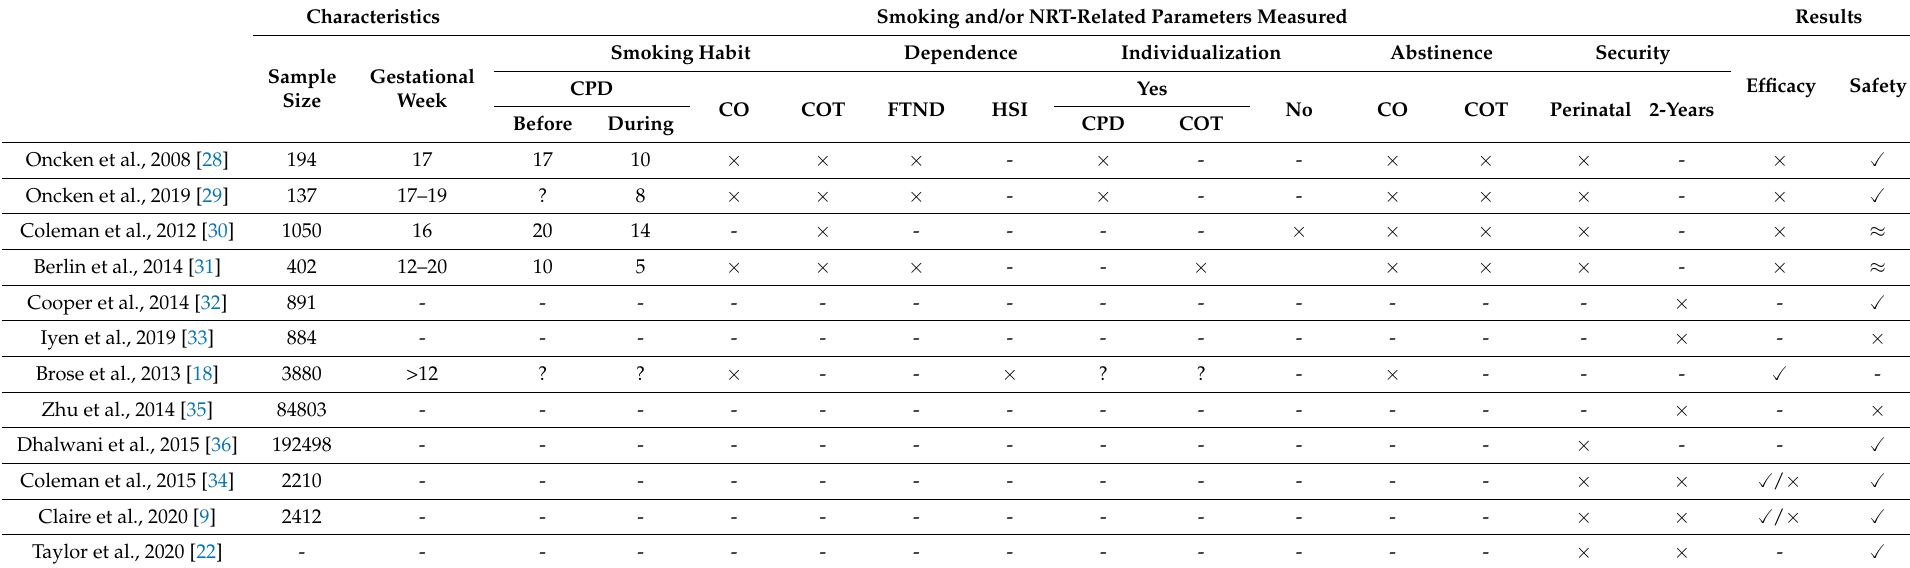
Table 1. Summary of selected articles on the use of nicotine replacement therapy during